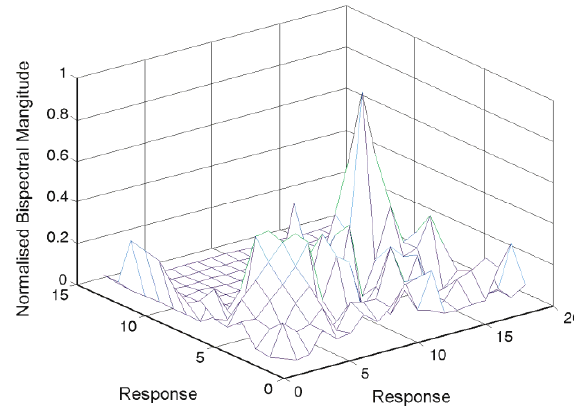
Fig. 6. Bispectrum of benefits in implementing waste manage- ment